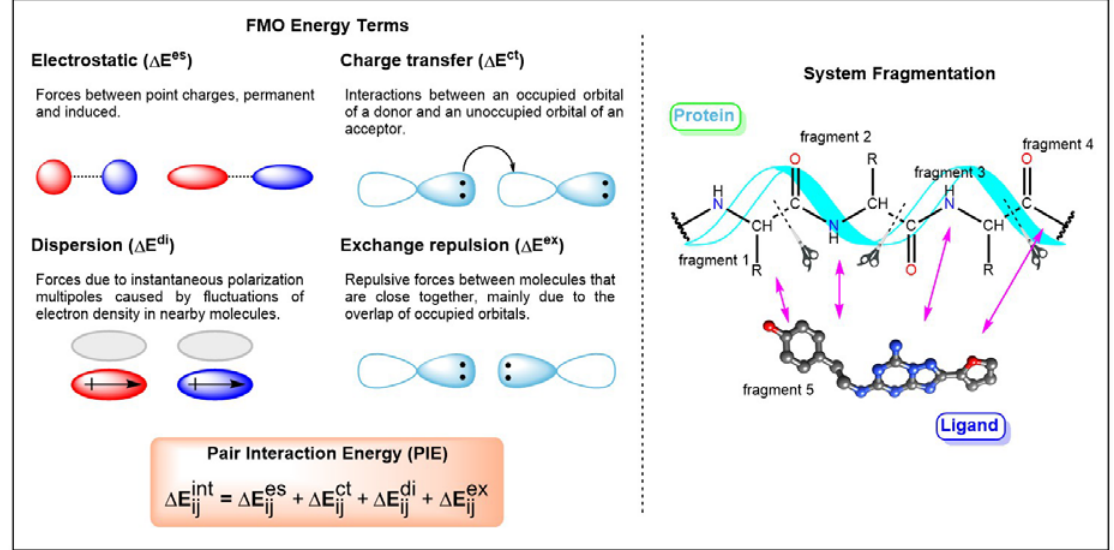
Figure 4. Workflow of the fragment molecular orbital (FMO) method and details of pair interaction energy (PIE) terms. Adapted from Reference 64 with permission.